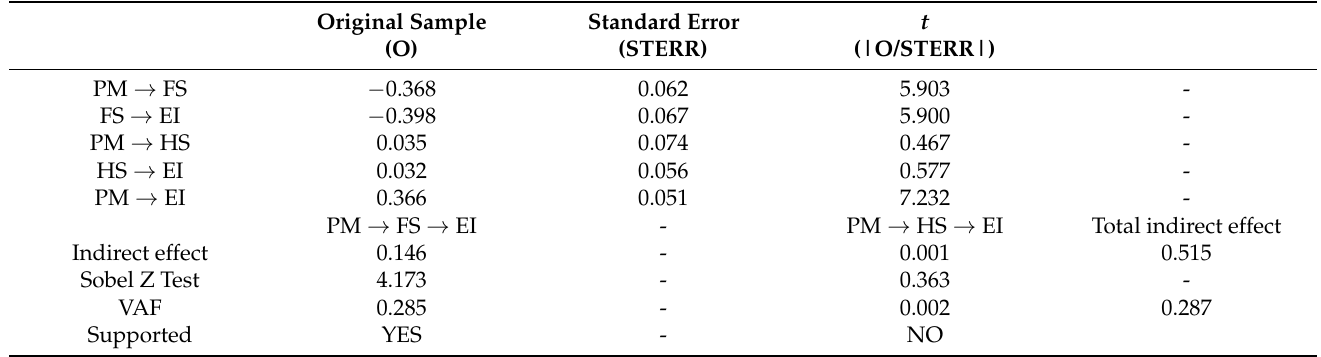
Table 6. Test of mediation effect.